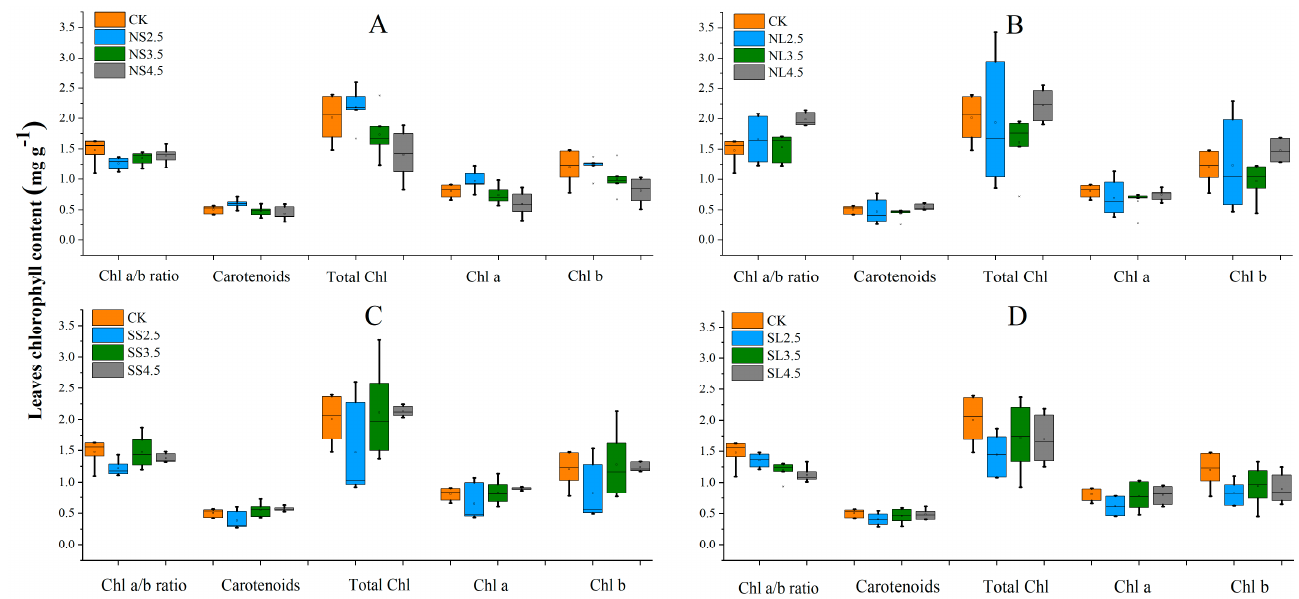
Figure 5. Effect of different forms of acid stress on different species’ chlorophyll content of Acer catalpifolium leaves. The treatments: CK, CK, NS ( A ), NL ( B ), SS ( C ) and SL ( D ) indicated are defined as control, nitric-balanced acid applied to soil, nitric-balanced acid applied to leaves, sulfuric-dominated acid applied to soil and sulfuric-dominated acid applied to leaves, respectively. The black dot in each of the boxes represents mean values and bars and stand for maximum or minimum value of each treatment (n = 10).